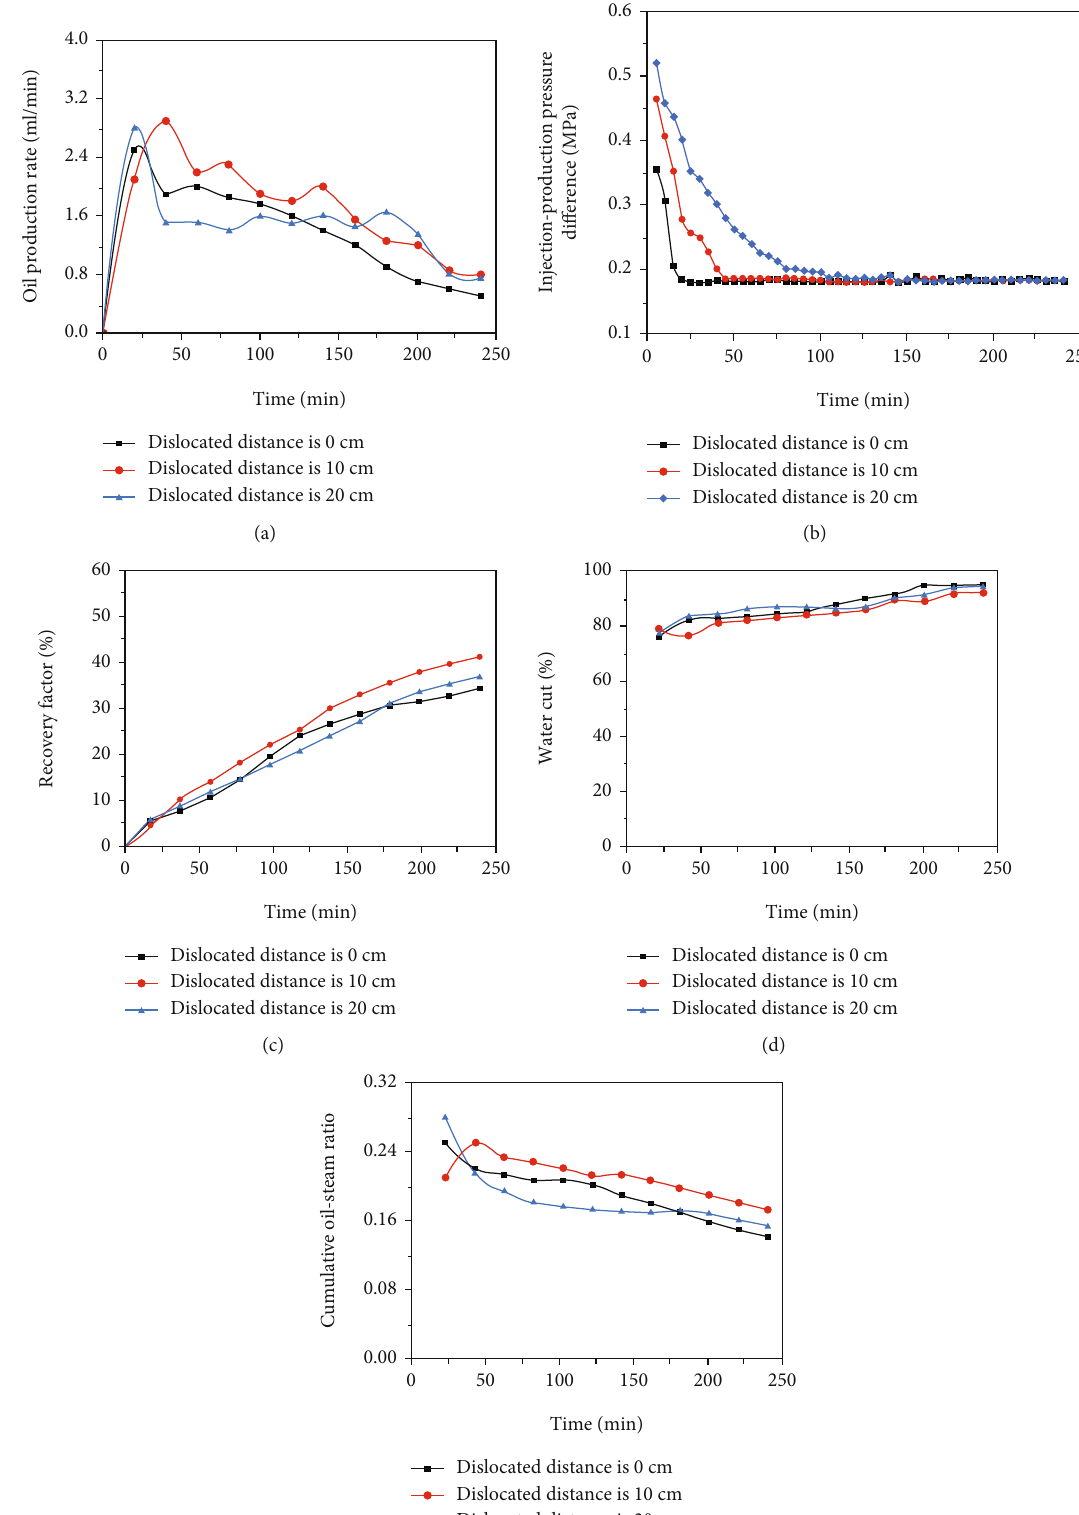
Figure 14: Comparison of production performance of three experiments. (a) Change of oil production rate with time. (b) Change of injection-production pressure di ff erence with time. (c) Change of recovery factor with time. (d) Change of water cut with time. (e) Change of cumulative oil-steam ratio with